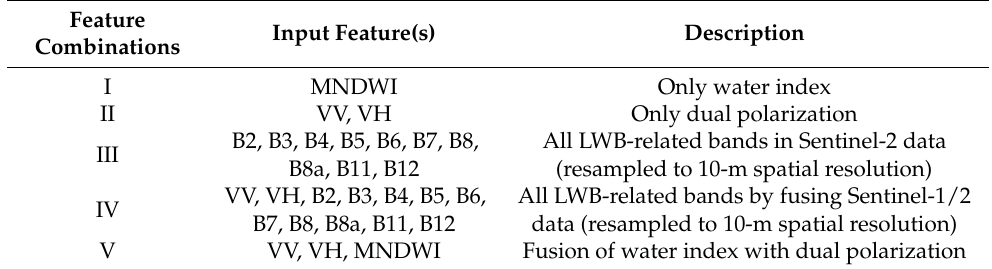
Table 3. Input feature combinations used in the